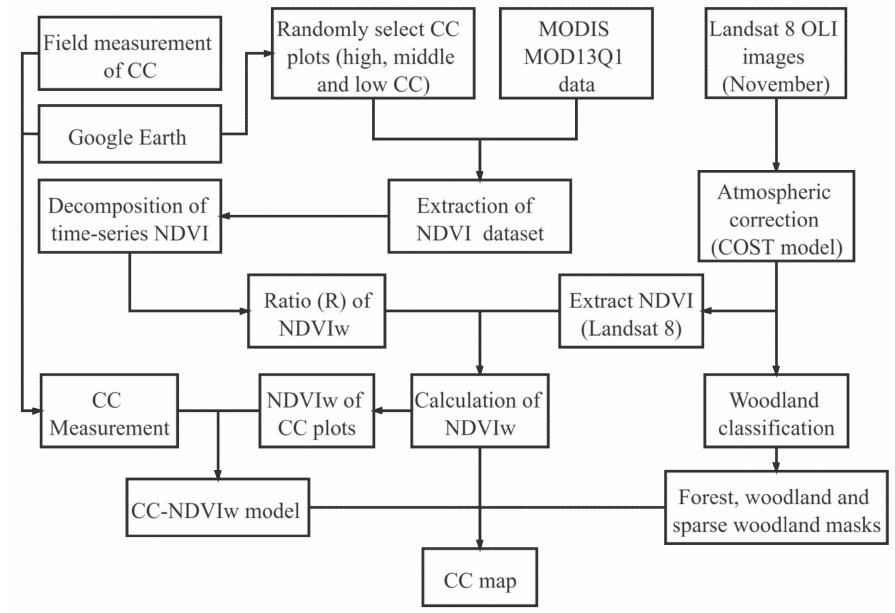
Figure 1. The overall methodological flowchart applied in this study.